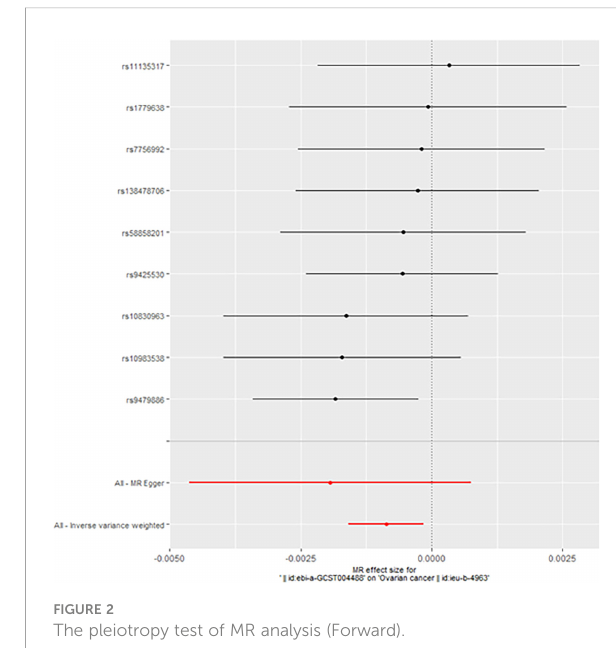
FIGURE 1 Mendelian randomization results of the association of the insulin secretion rate on ovarian cancer (Forward).